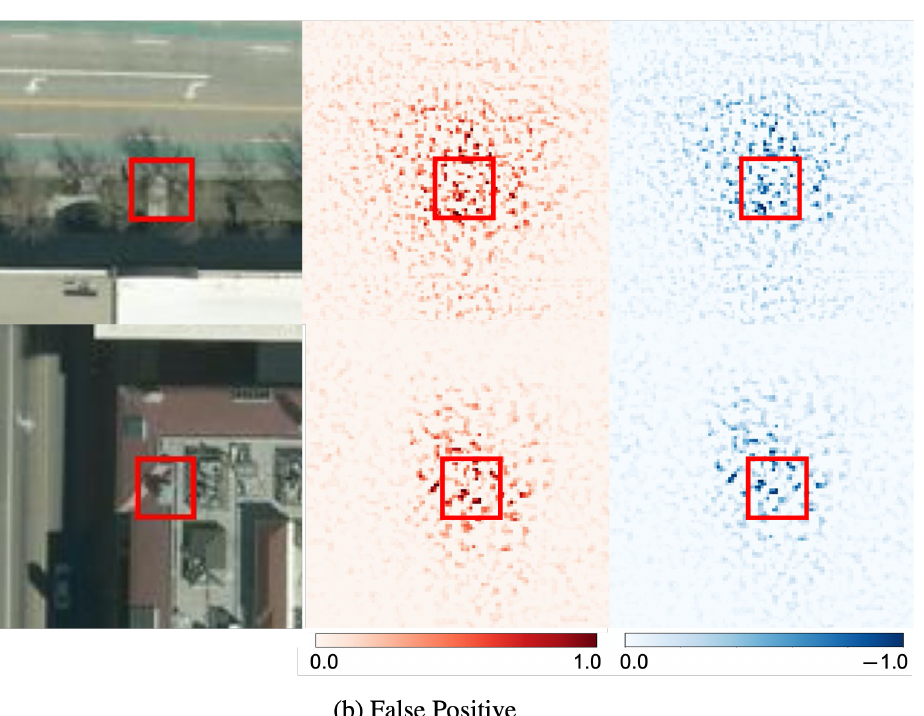
Figure 6. Visualization results of positive outputs using pixel-wise Gradient SHAP. The left image shows the inferred results, the center image shows the distribution of positive values, and the right image shows the negative